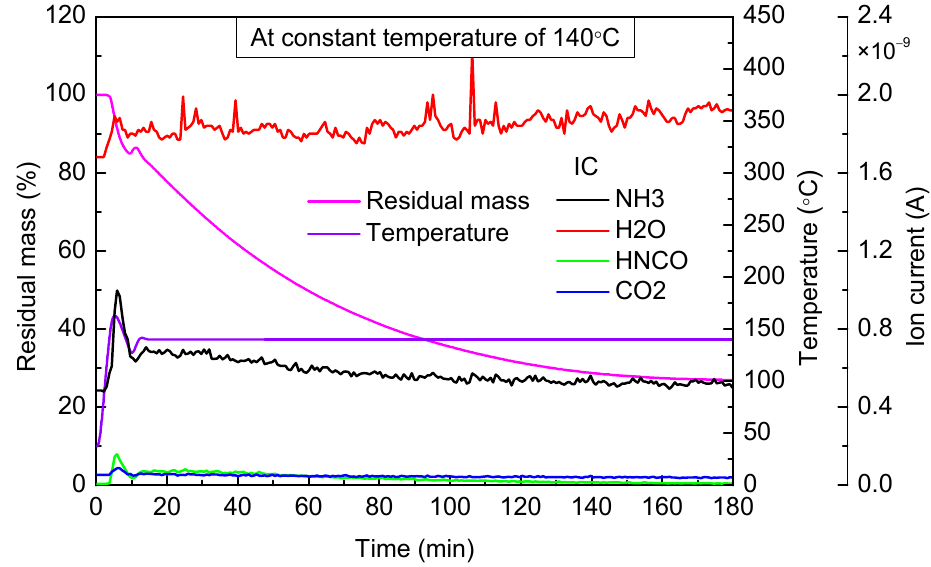
Figure 2. TG-MS results of urea at constant temperature of 140 °C .